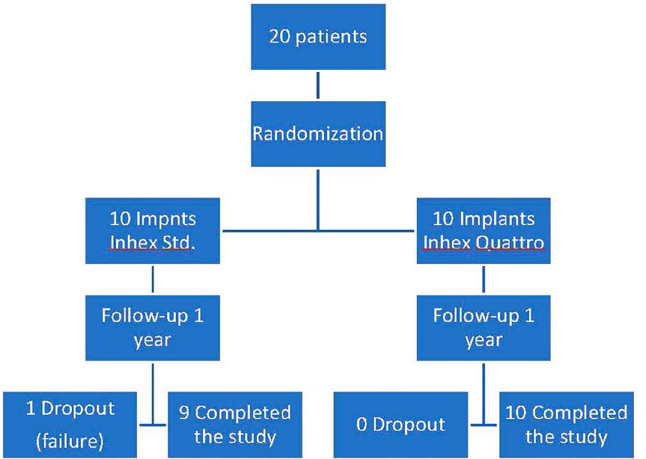
Figure 2. Protocol for randomized distribution of the sample. Distribution of the sample and the final number of dropouts and samples with completion of the study.